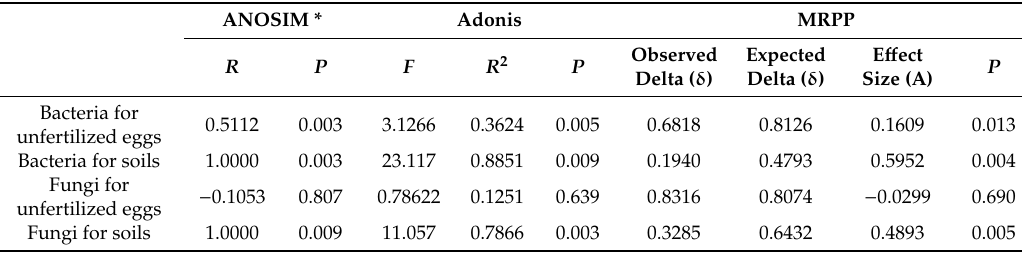
Figure 3. PCoA plots based on Weighted Unifrac distances of OTU profiles of unfertilized eggs ( a , b ) and soil ( c , d ) samples. A, B, and C present different sampling sites with high, low, and null Chinese cordyceps, respectively. Blue, green, and red circles represent samples from sites A, B, and C, respectively. Table 2. Dissimilarity comparison of unfertilized eggs / soil microbial community structures among the three sampling